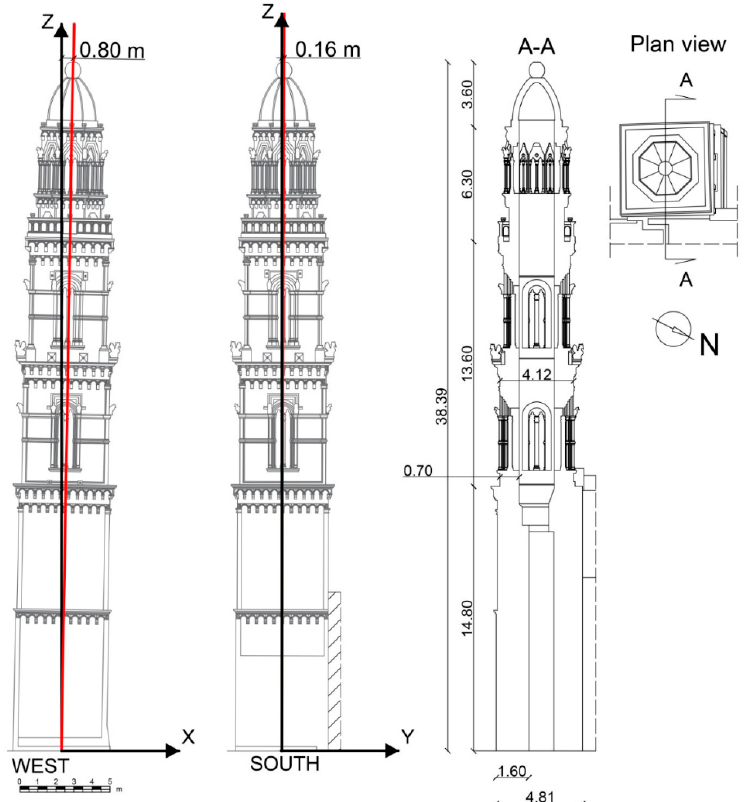
Figure 8. Inclination of the bell-tower relief ( left ) and longitudinal section ( right )—all dimensions in meters.